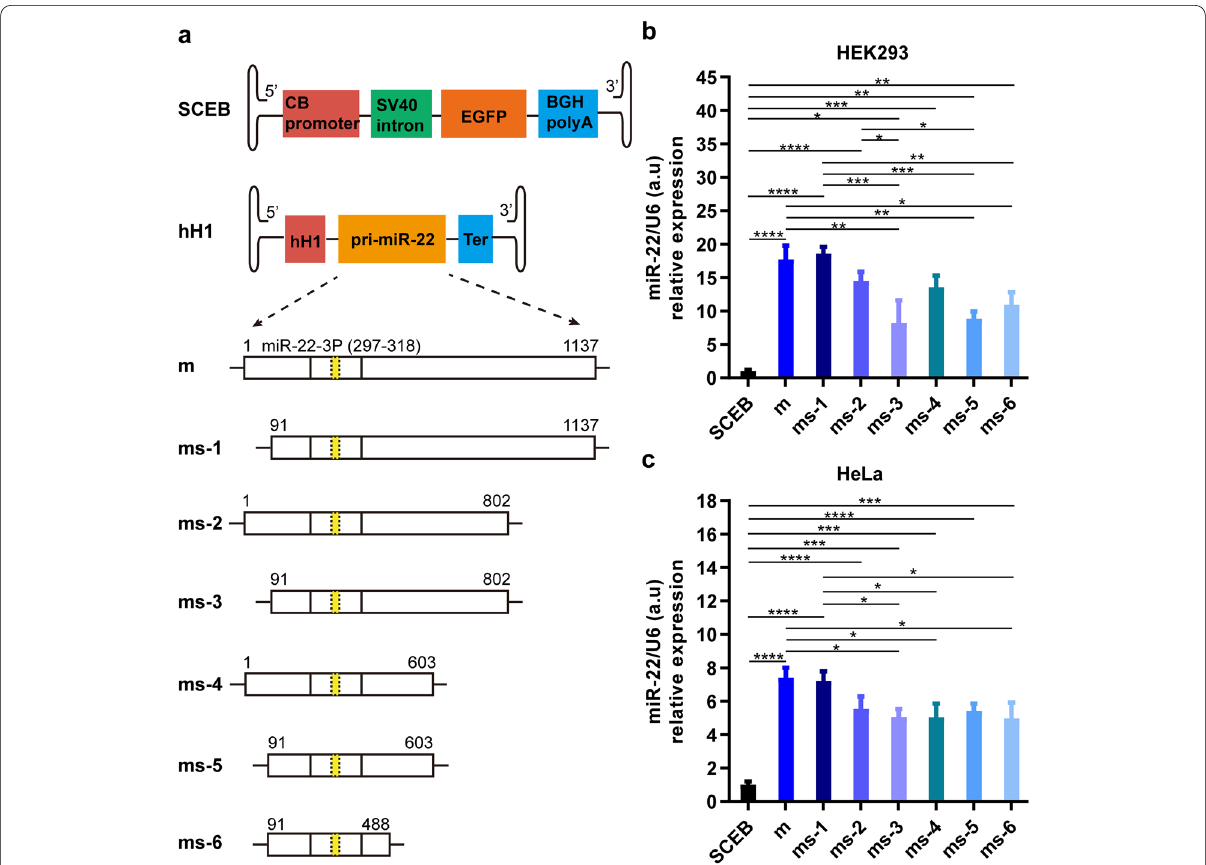
Fig. 1 Expression comparisons by varying pri-miR-22 lengths in cells. a Schematic diagram of the rAAV vector plasmids containing different lengths of pri-miR-22 driven by the hH1 promoter. CB, chicken β-actin promoter with the CMV enhancer; hH1, human H1 promoter; Ter, TTT TTT sequence, and the termination signal for miRs. miR-22-3p was indicated in yellow and ms1-6 represented different lengths of shortened pri-miR-22. b Expression levels of different lengths of miR-22 in HEK293 cells. c Expression levels of different lengths of miR-22 in HeLa cells. All data were represented as Mean SD, and error bars were based on triplicated samples. * P < 0.05, ** P < 0.01, *** P < 0.001 and **** P < ±